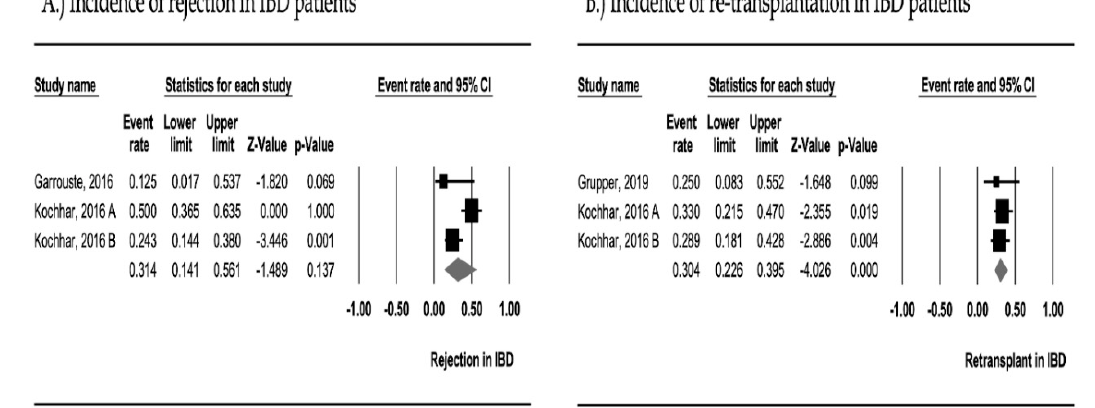
Figure 3. Forest plot of meta-analysis on ( A ) the pooled incidence of graft rejection in inflammatory bowel disease patients (I 2 76.9%; Egger’s intercept 0.601) and ( B ) the pooled incidence of re-transplantation in inflammatory bowel disease patients (I 2 0%; Egger’s intercept 0.481).